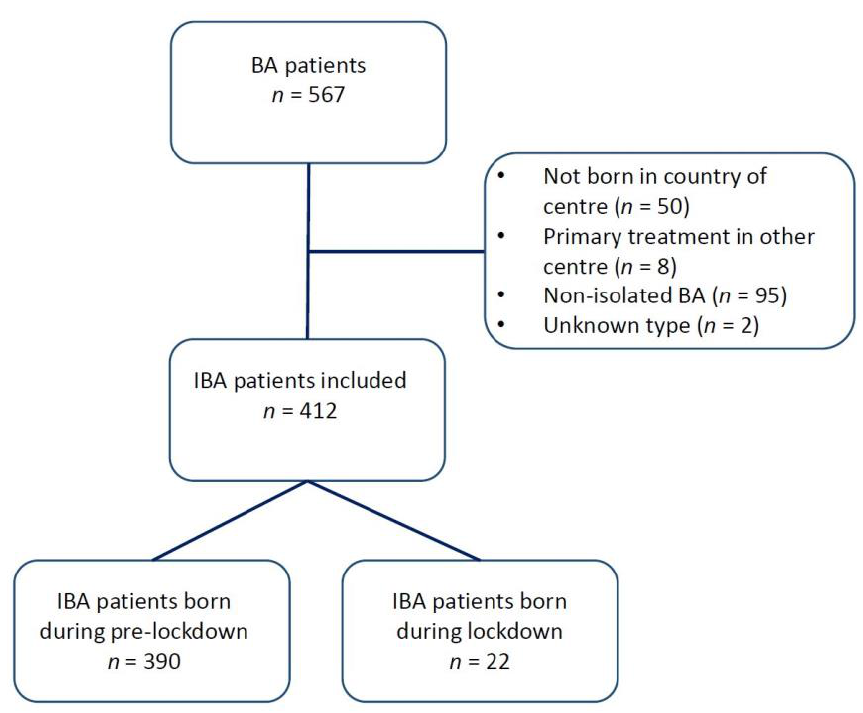
Figure 1. Flowchart of patients included in this study. Table 1. An overview of the participating centres and the number of BA patients that were treated in each centre and born between 1 January 2015 and 31 May 2020. A distinction is made between IBA and non-IBA patients. IBA patients were included in this study.